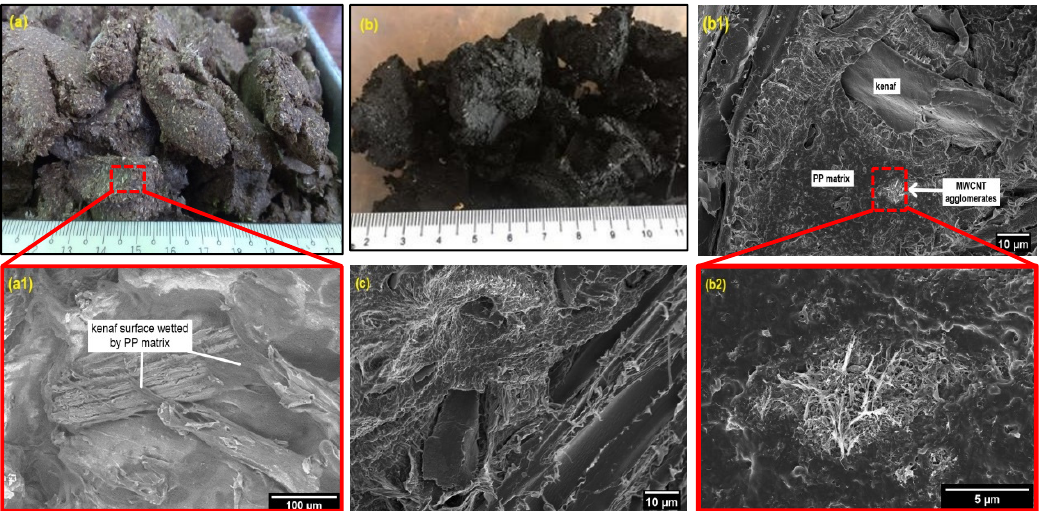
Figure 4. The physical state of ( a ) PP / 30 K feedstock and ( b ) PP / 30 K / 3 MCT feedstock after mixing, Figure 4 . The physical state of ( a ) PP/30 K feedstock and ( b ) PP/30 K/3 MCT feedstock after mixing, with the FESEM image of ( a1 ) PP / 30 K and ( b1 ) PP / 30 K / 3 MCT with the enlargement ( b2 ) and the with the FESEM image of ( a1 ) PP/30 K and ( b1 ) PP/30 K/3 MCT with the enlargement ( b2 ) and the image of ( c ) PP / 30 K / 3 MCT with 3 wt % maleic anhydride-grafted polypropylene (MAPP) additions. image of ( c ) PP/30 K/3 MCT with 3 wt % maleic anhydride ‐ grafted polypropylene (MAPP) additions.